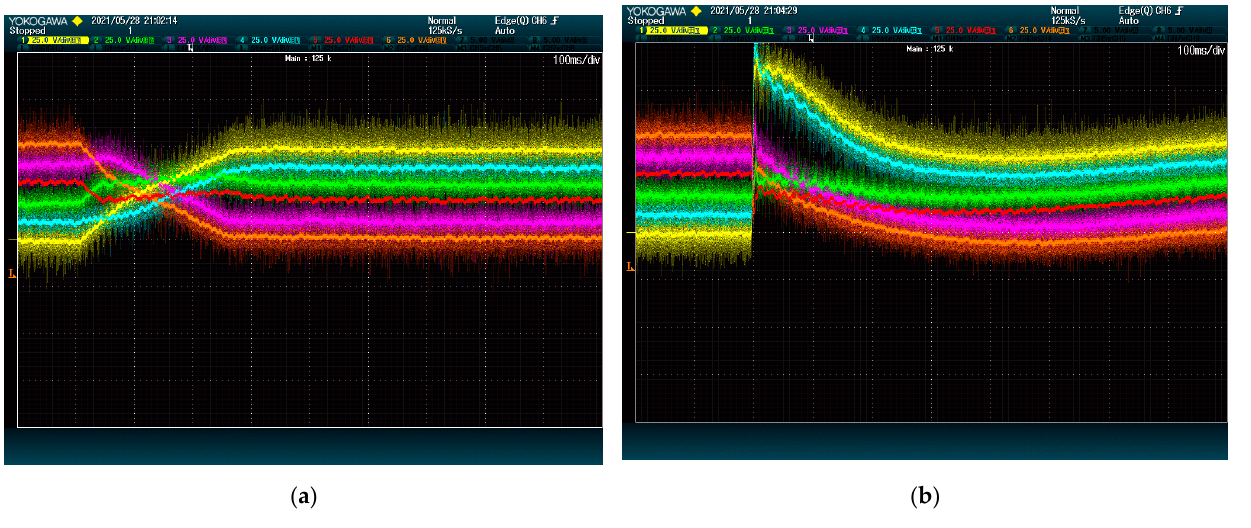
Figure 9. DC-Link voltage dynamics upon set point swap at 1 kVAr: ( a ) proposed method; ( b ) state-of-the-art alternative. The plots show voltage (25 V/div) vs. time (100 ms/div).